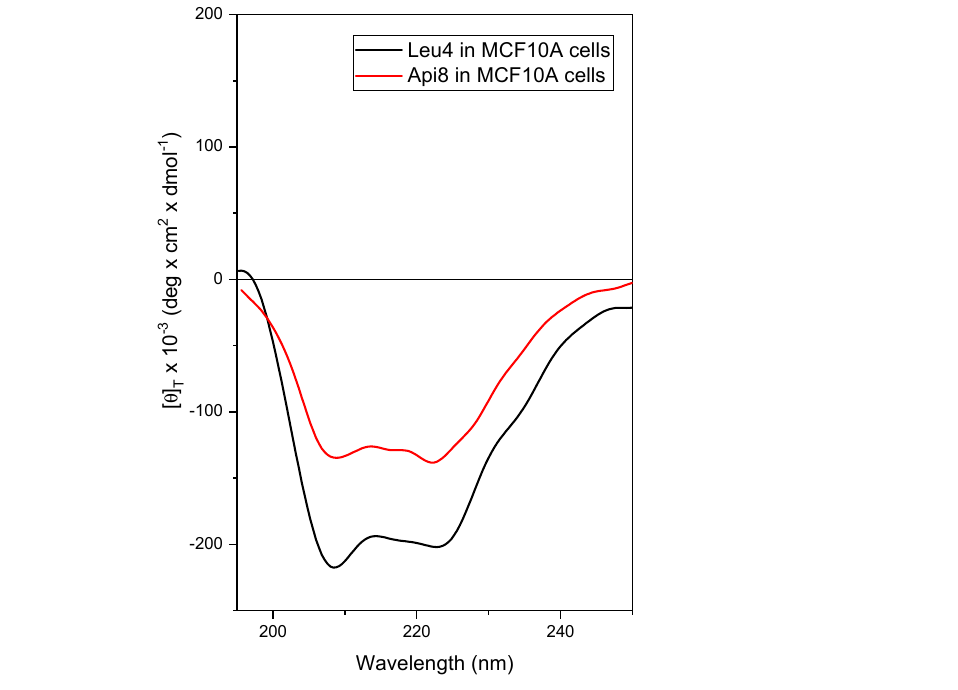
Figure 1. CD profiles of Leu4-NH2 and Api8-NH2 acquired at 25 °C in the presence of MCF-10A epithelial breast cells. (Peptide concentrations: Api8, 5 × 10 − 5 M; Leu4, 1 × 10 − 5 M).